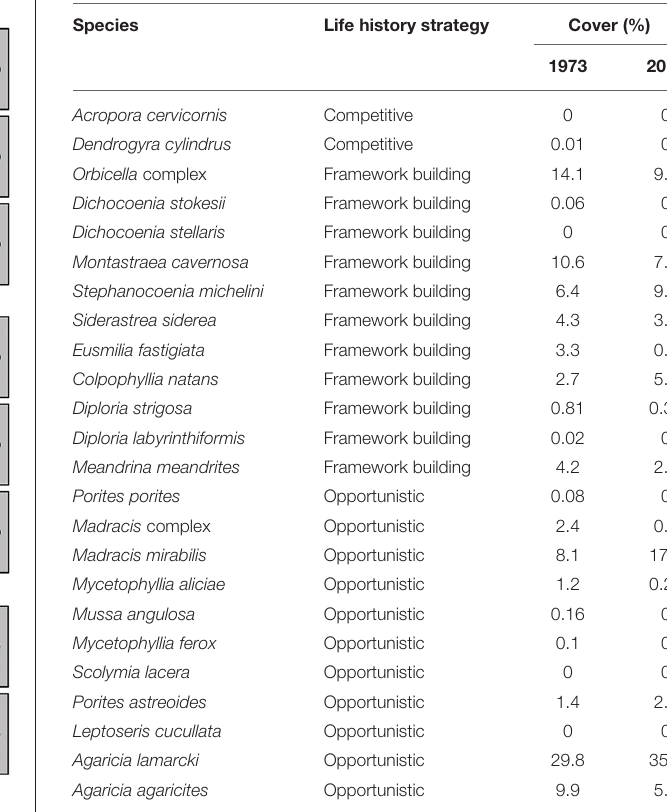
TABLE 4 | Species specific life-history strategy and